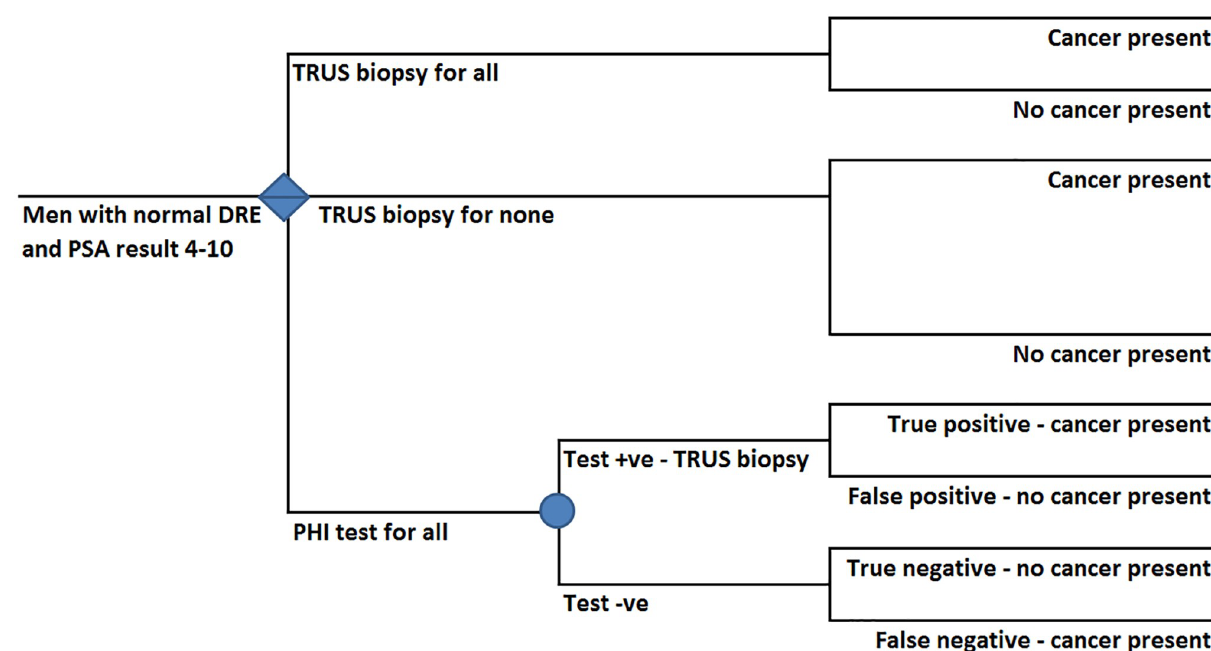
Fig 1. Decision tree illustrating diagnostic strategies for men with suspected prostate cancer, normal digital rectal examination and prostate specific antigen level 4–10 in Hong Kong. DRE–Digital Rectal Examination, PHI–Prostate Health Index, PSA—Prostate Specific Antigen, TRUS– Transrectal Ultrasound-guided biopsy. Diamond represents a decision node. Circle represents a probability node.